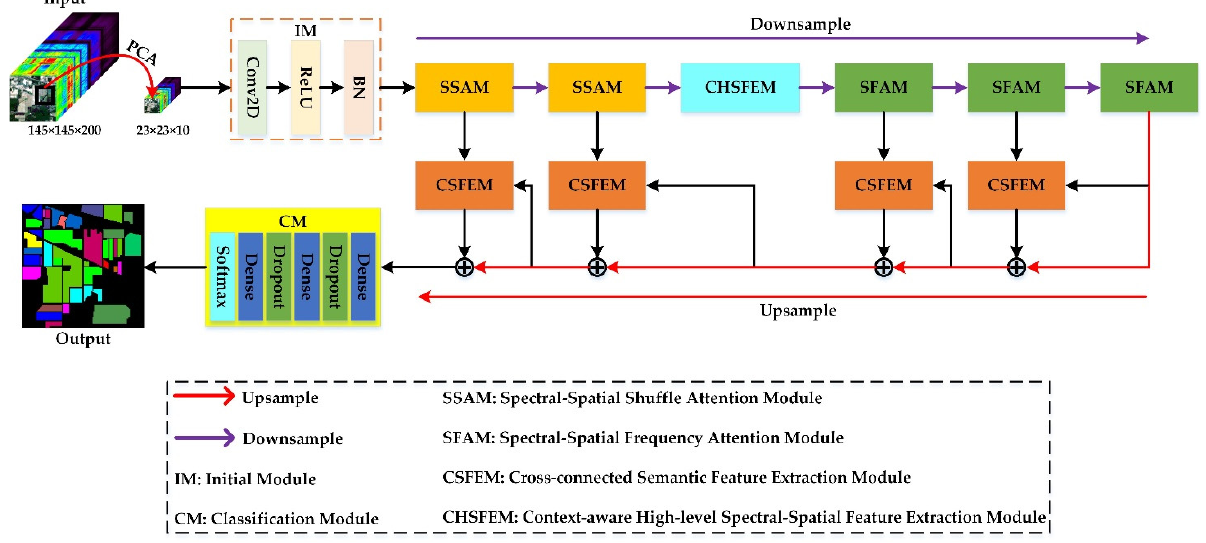
Figure 1. The architecture of the proposed DSFNet.